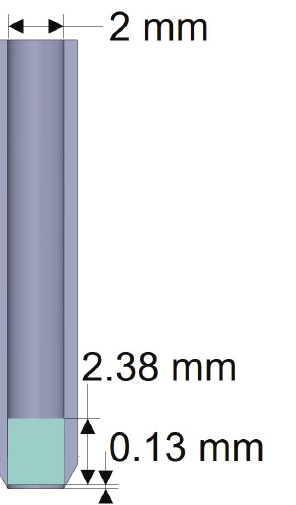
Figure 1. Schematic representation and illustration of the inner stopper guarded